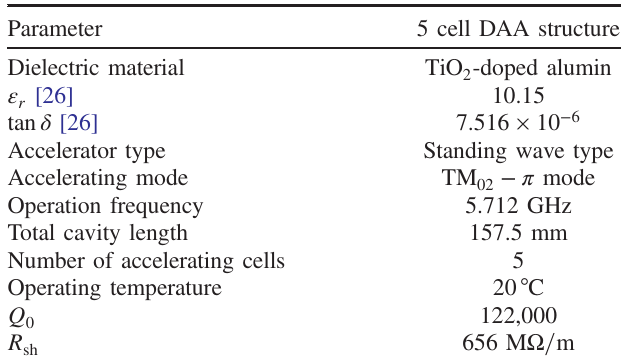
TABLE II. Basic cavity and accelerator parameters of an optimized 5 cell DAA